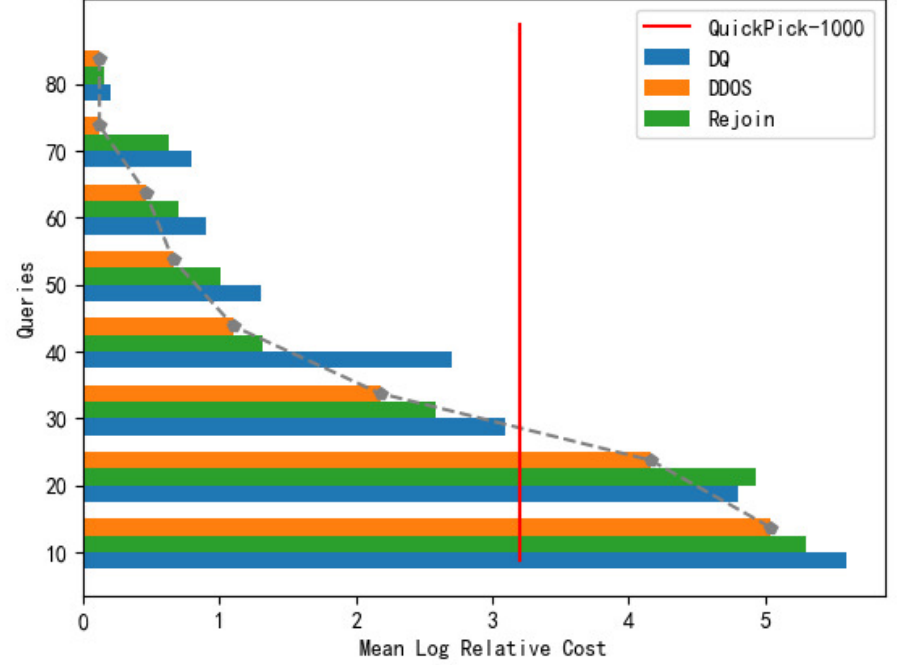
Figure 7. Comparison of the mean relative cost (in log scale) of DDOS, Rejoin and